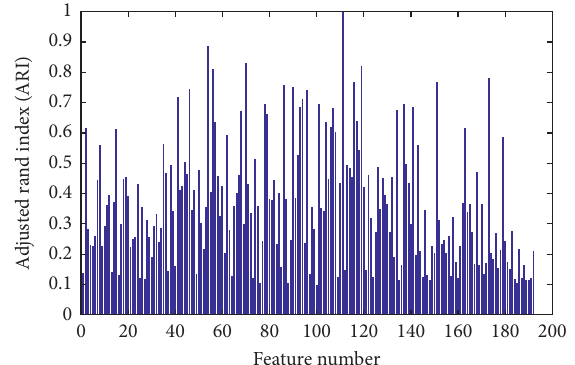
Figure 9: The adjust rand index.